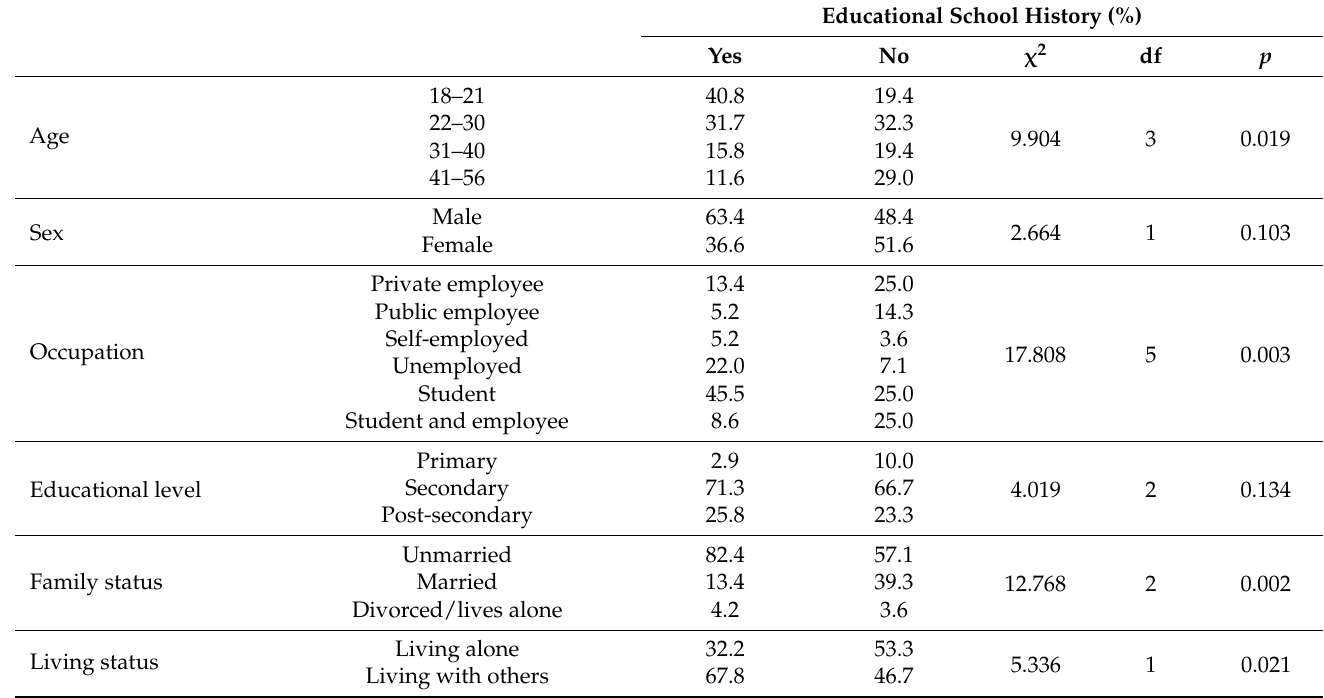
Table A7. Relationship of the Educational school history of the assessed adults with the other variables.